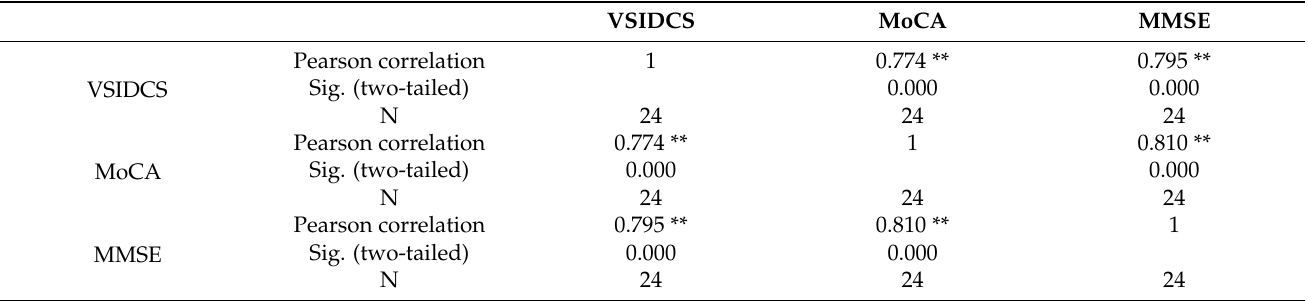
Table 3. Correlation analysis of VSIDCS, MoCA, and MMSE